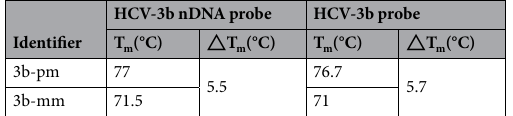
Table 2. Melting temperatures of probe/target duplexes in 100 mM BTP